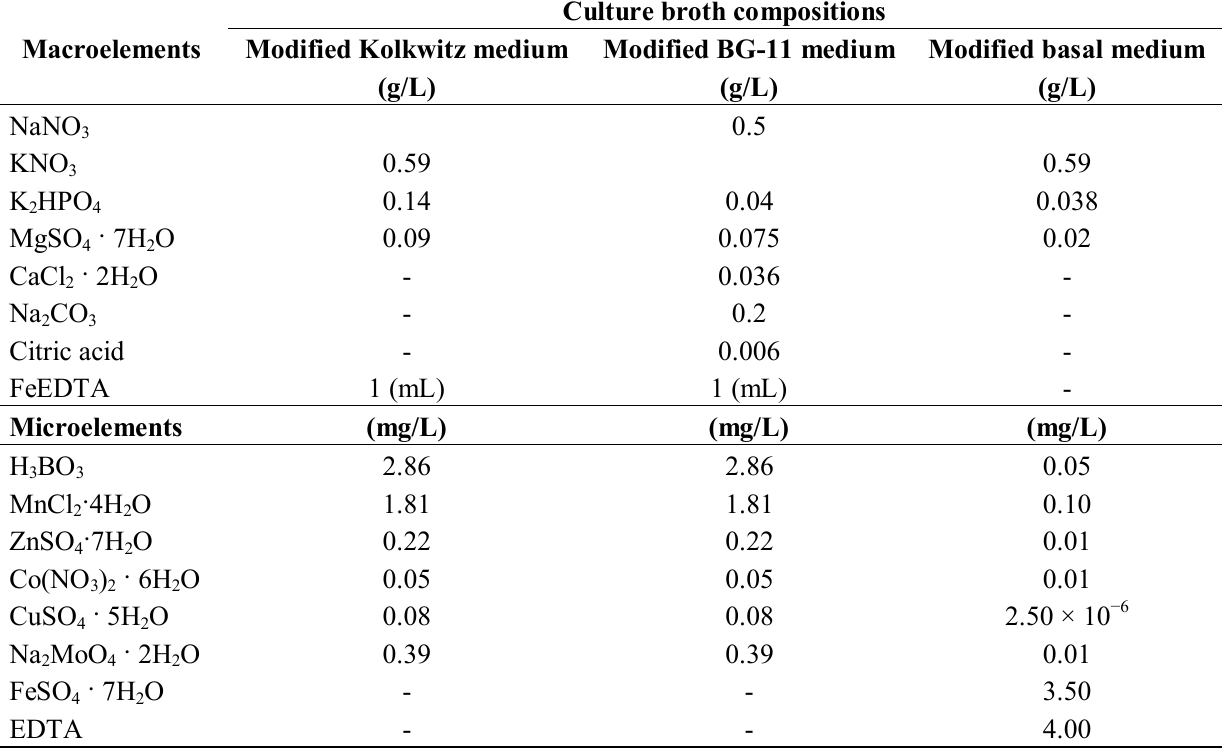
Table 1. Chemical composition of the culture broths